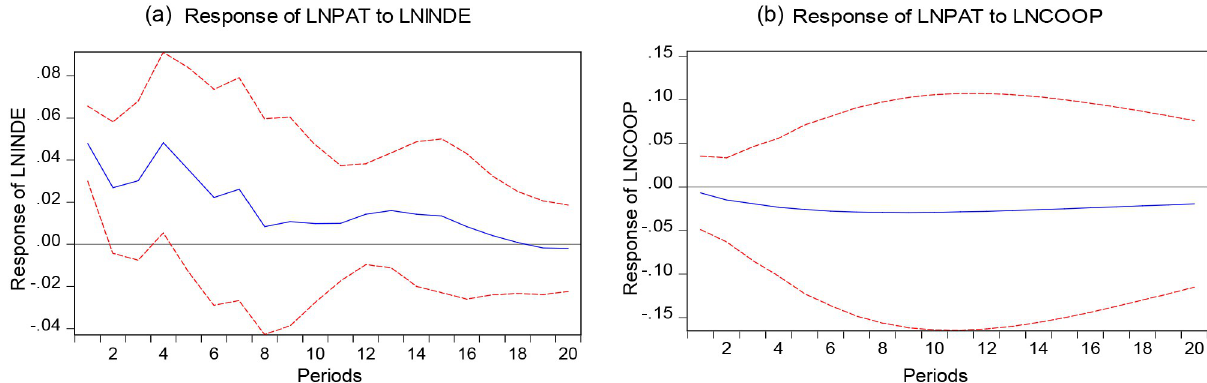
Fig 3. Impulse responses of LNPAT to LNINDE, LNCOOP. Note: The red dashed part is the confidence band with plus or minus two standard deviations, and the solid blue part is the calculated value.